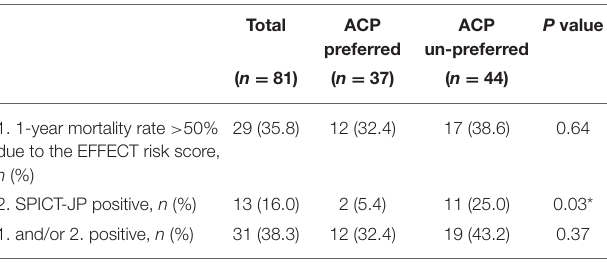
TABLE 5 | Medical Preferences among patients who requested advance care planning